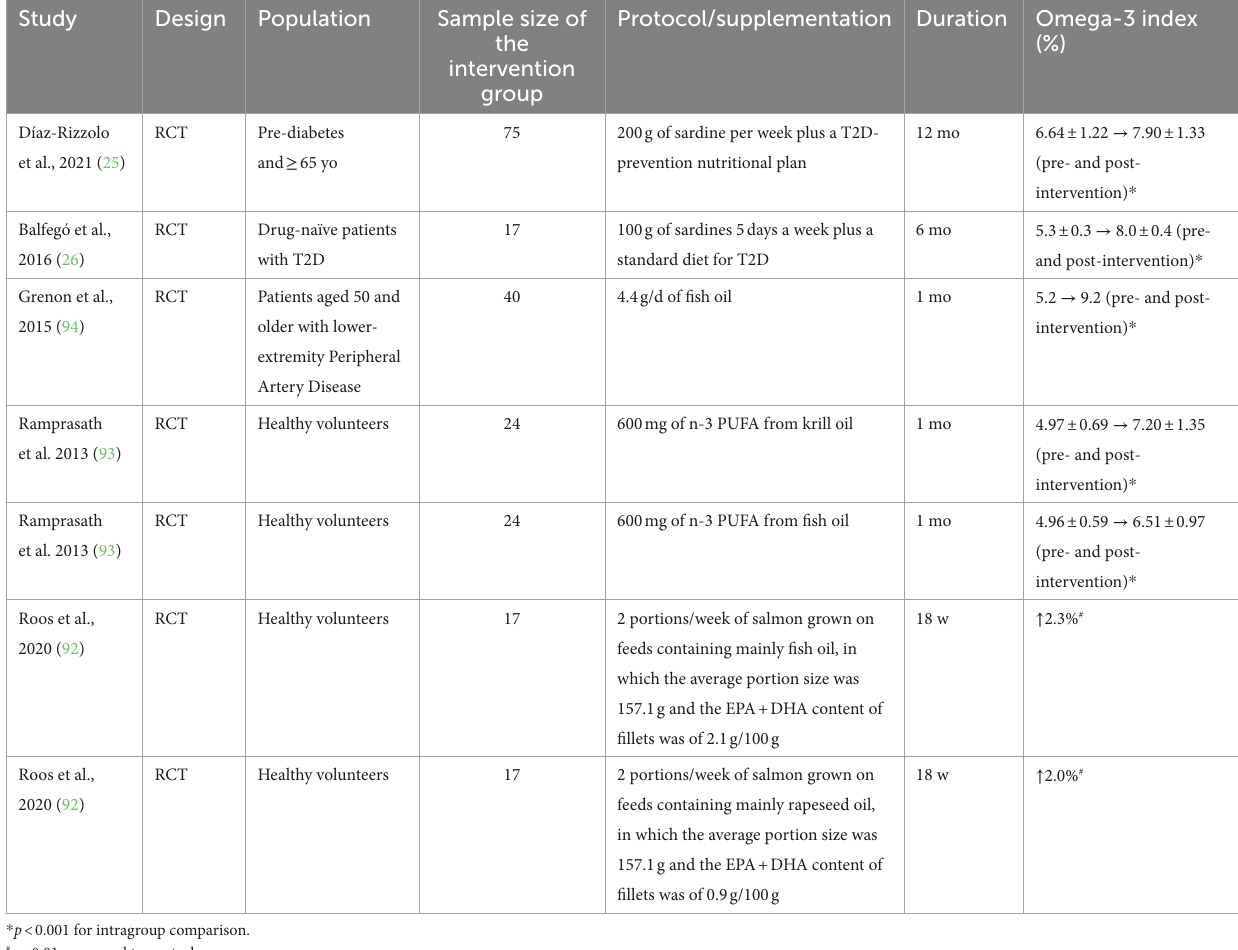
TABLE 2 The effects of sardine interventions compared to other sources of omega-3 (fish oil supplementation and salmon) on the omega-3